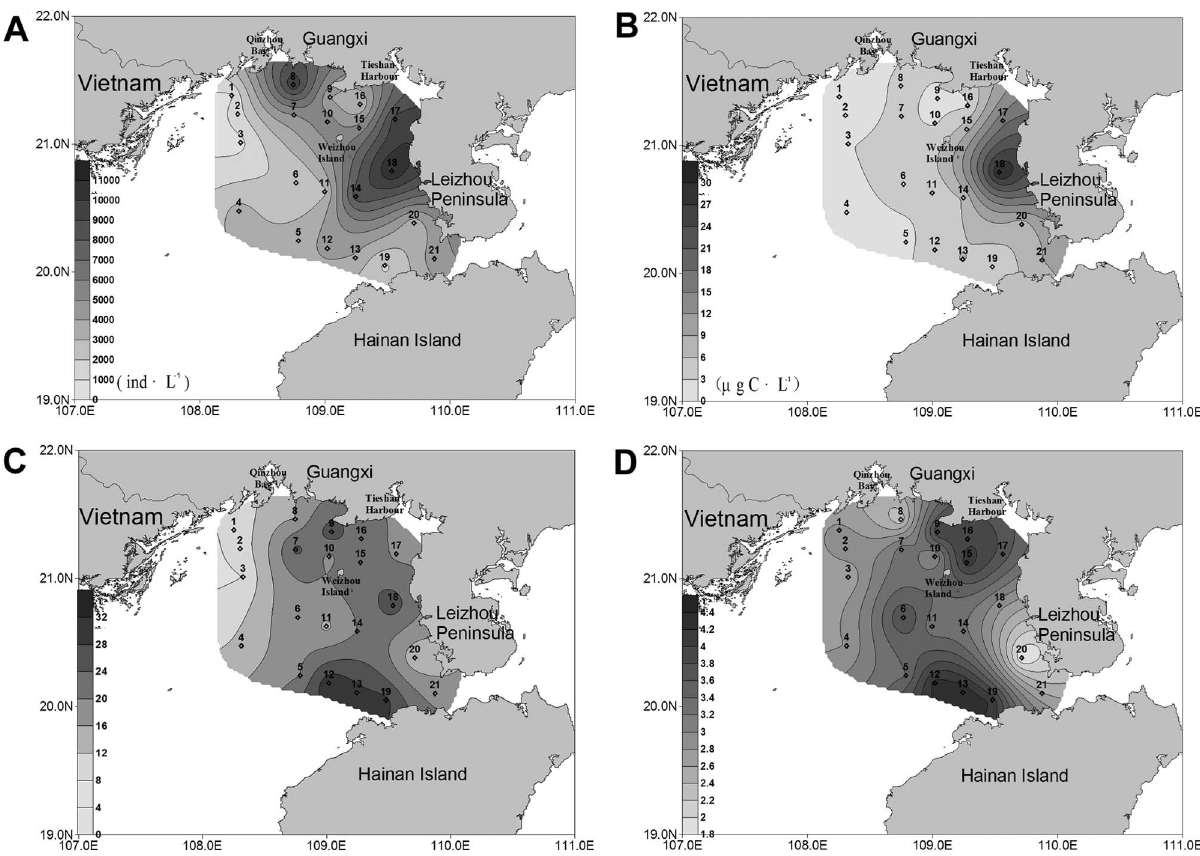
Figure 3. Horizontal distribution of planktonic ciliates in the bottom layer of the northern Beibu Gulf. (A) Horizontal distribution of abundance. (B) Horizontal distribution of biomass. (C) Horizontal distribution of species number. (D) Horizontal distribution of diversity. The horizontal axis and the vertical axis expressed the gradients in longitude and latitude, respectively. (TIFF).